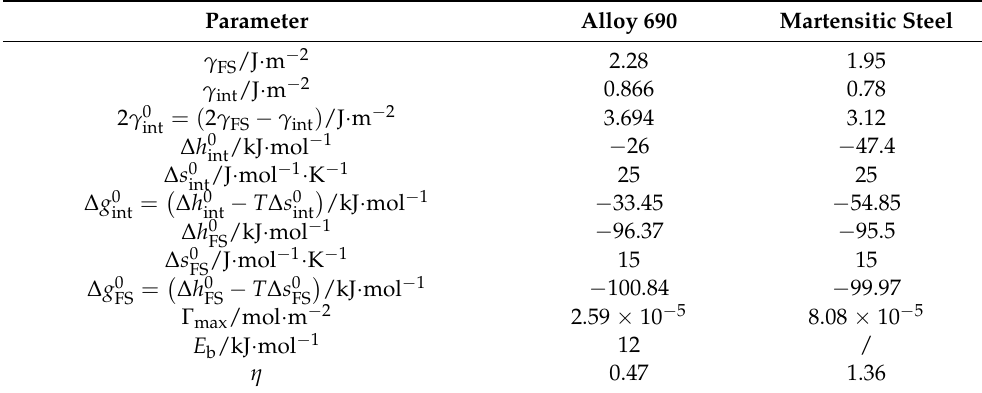
Table 1. Thermodynamic decohesion parameters recommended in the literature for Inconel 690 alloy [27] and high-strength martensitic steel